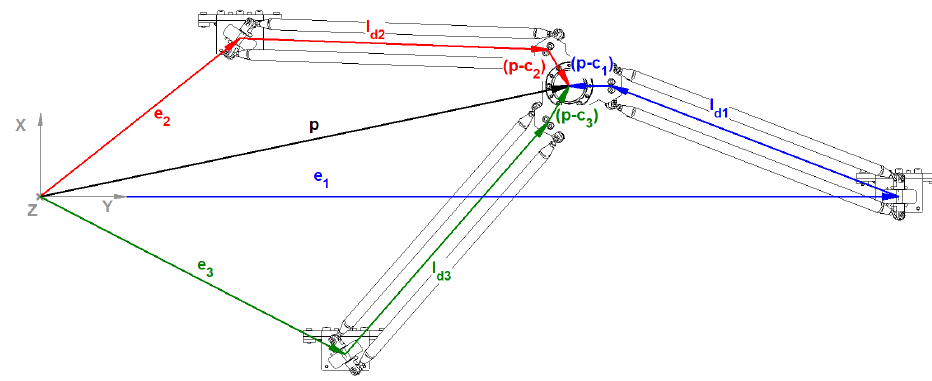
Figure 6. Vector loops for the three kinematic